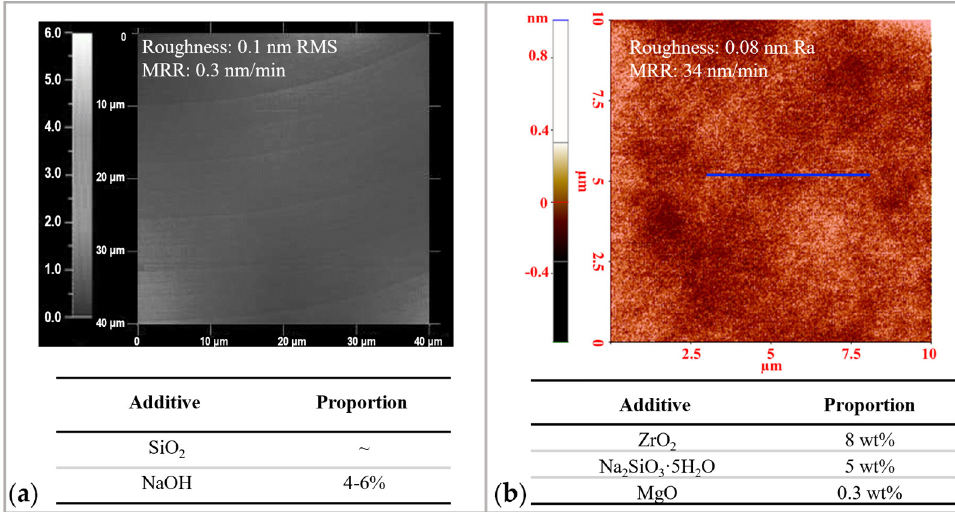
Figure 6. The CMP recipe and AFM image of polished YAG: ( a ) Commercial recipe with SiO2. Reproduced with permission from [73]; ( b ) Novel recipe with Na2SiO3 · 5H2O reagent. Reproduced with permission from [71].